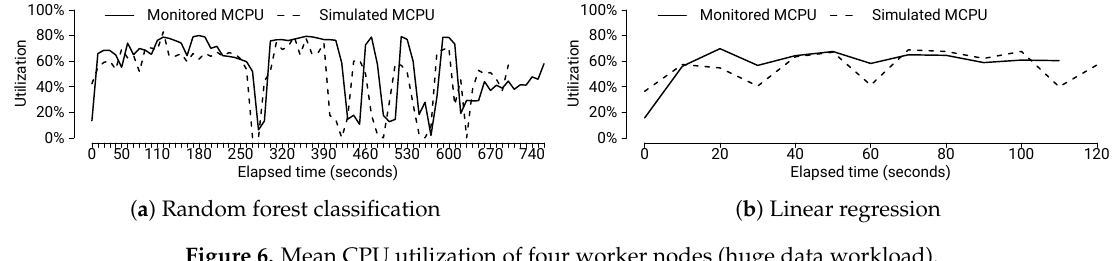
Figure 6. Mean CPU utilization of four worker nodes (huge data